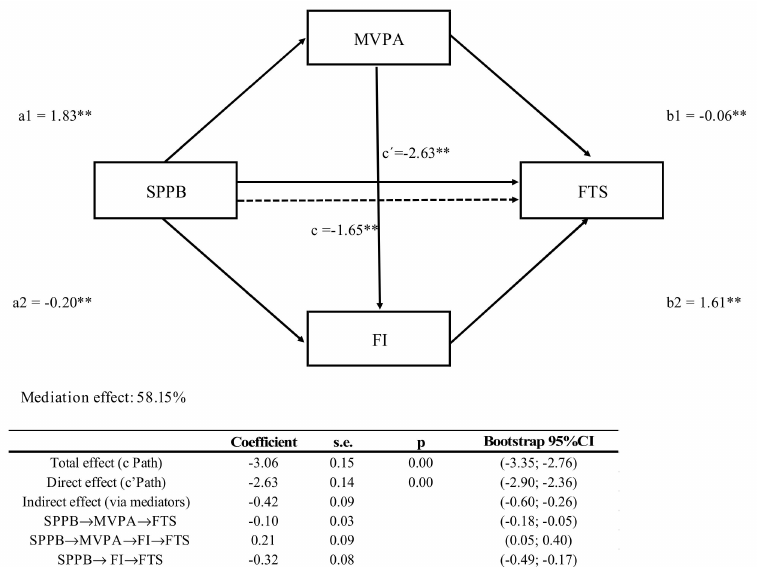
Figure 2. Multiple mediation model of the association between physical fitness (SPPB) and frailty (FTS) with moderate-to-vigorous physical activity (MVPA) and fat index (FI) as mediators in older adults. * p < 0.05; ** p < 0.001. Model was adjusted for age, sex and educational